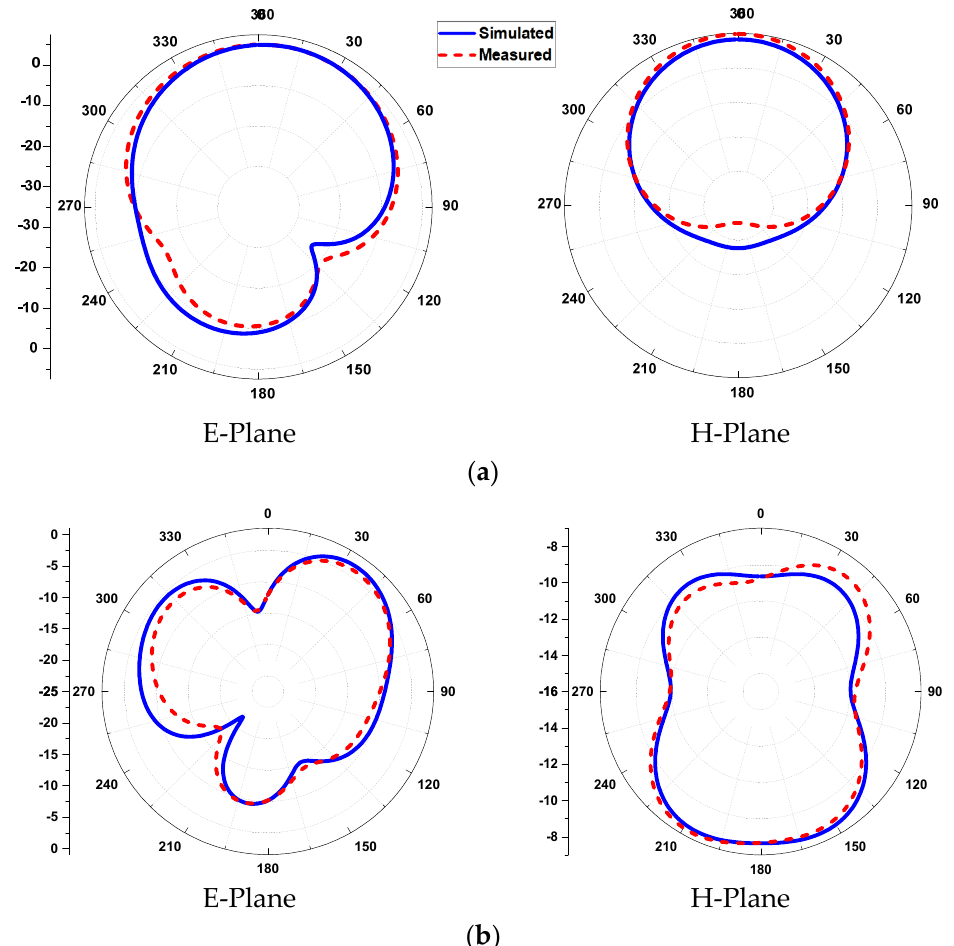
Figure 11. 2D pattern of the antenna in free space, ( a ) at 2.45 GHz and ( b ) at 5.8 GHz.